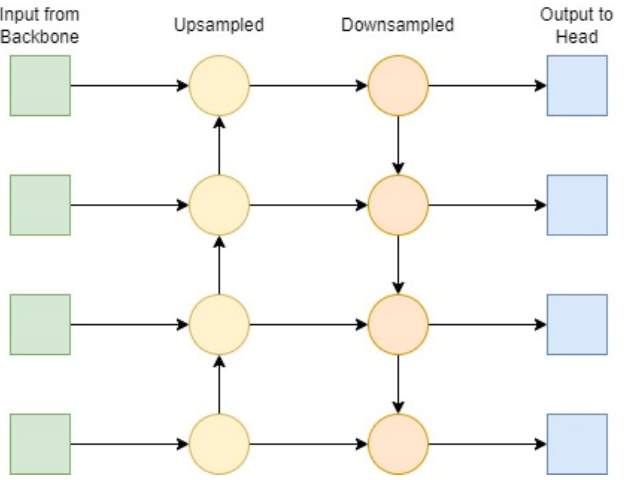
Figure 6. A graphical representation of the PANet implementation of neck of the proposed NextDet.